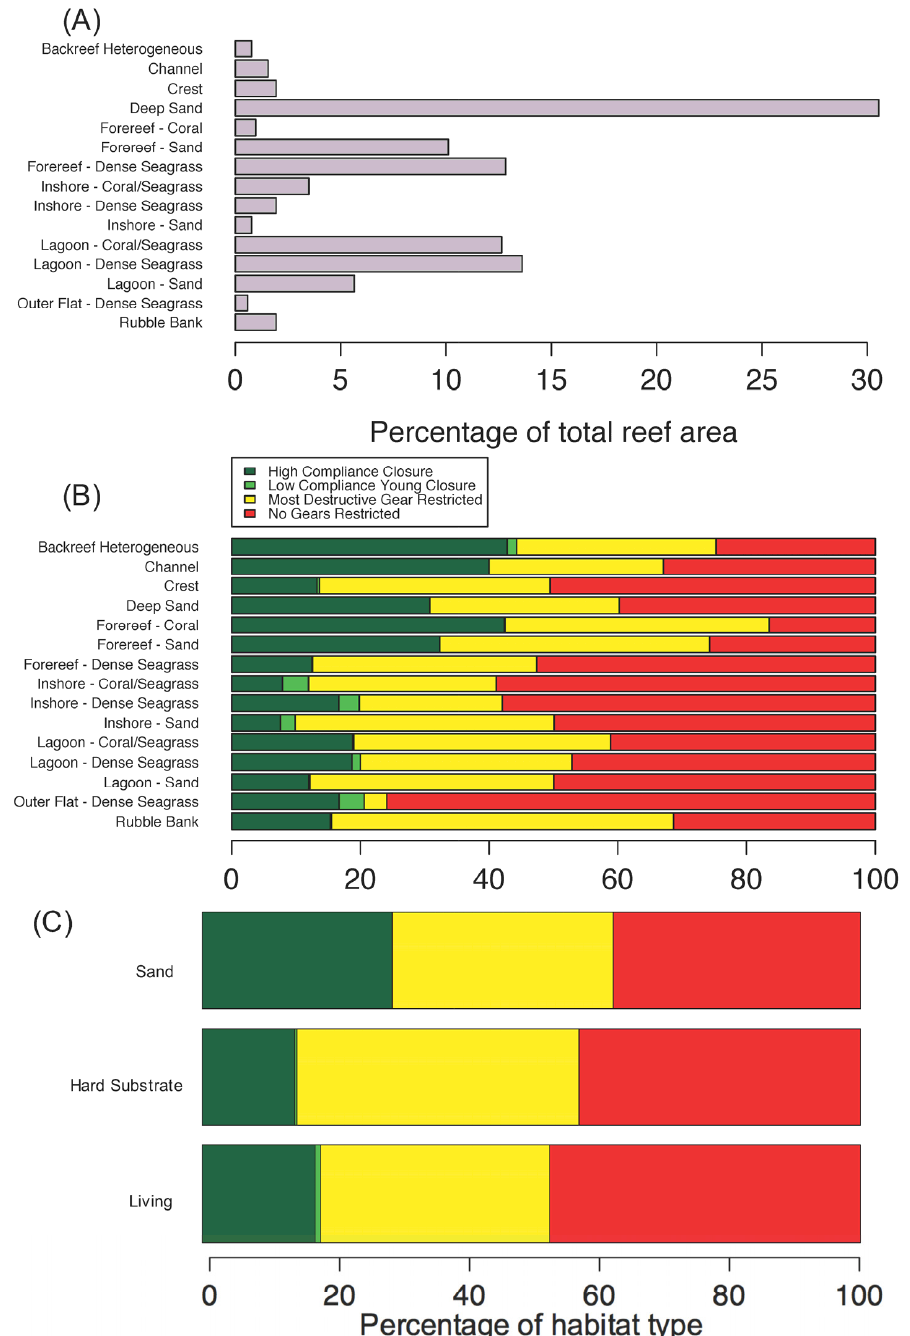
Figure 2. Habitat types across four fisheries management categories ( A ) as a proportion of total fringing reef area; ( B ) as a proportion within each of the four fisheries management categories; and ( C ) grouped into three broad habitat groups.